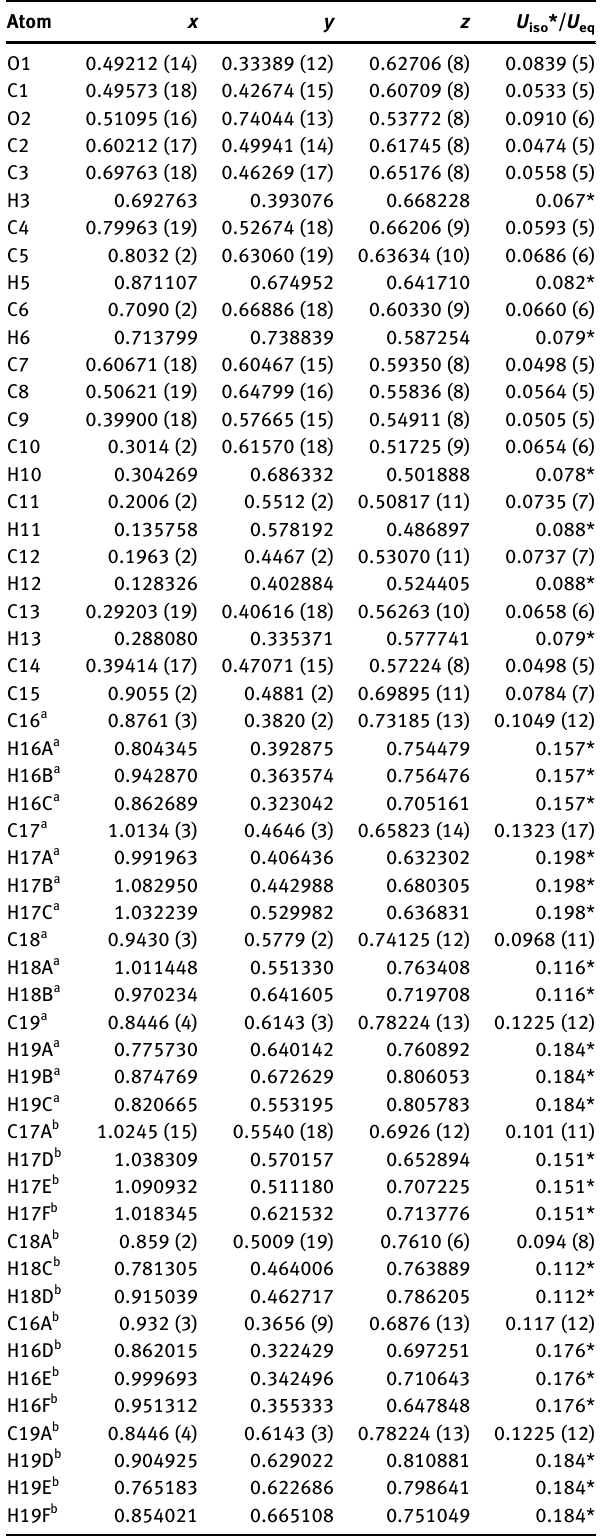
Table  : Fractional atomic coordinates and isotropic or equivalent isotropic displacement parameters (Å 